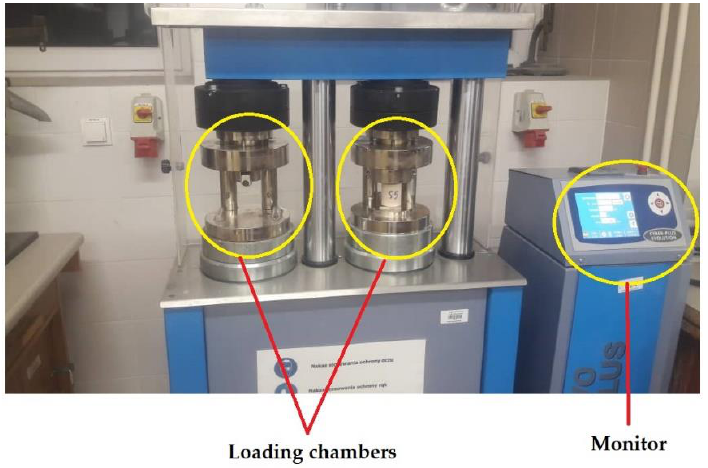
Figure 3. The UCS measurement apparatus.